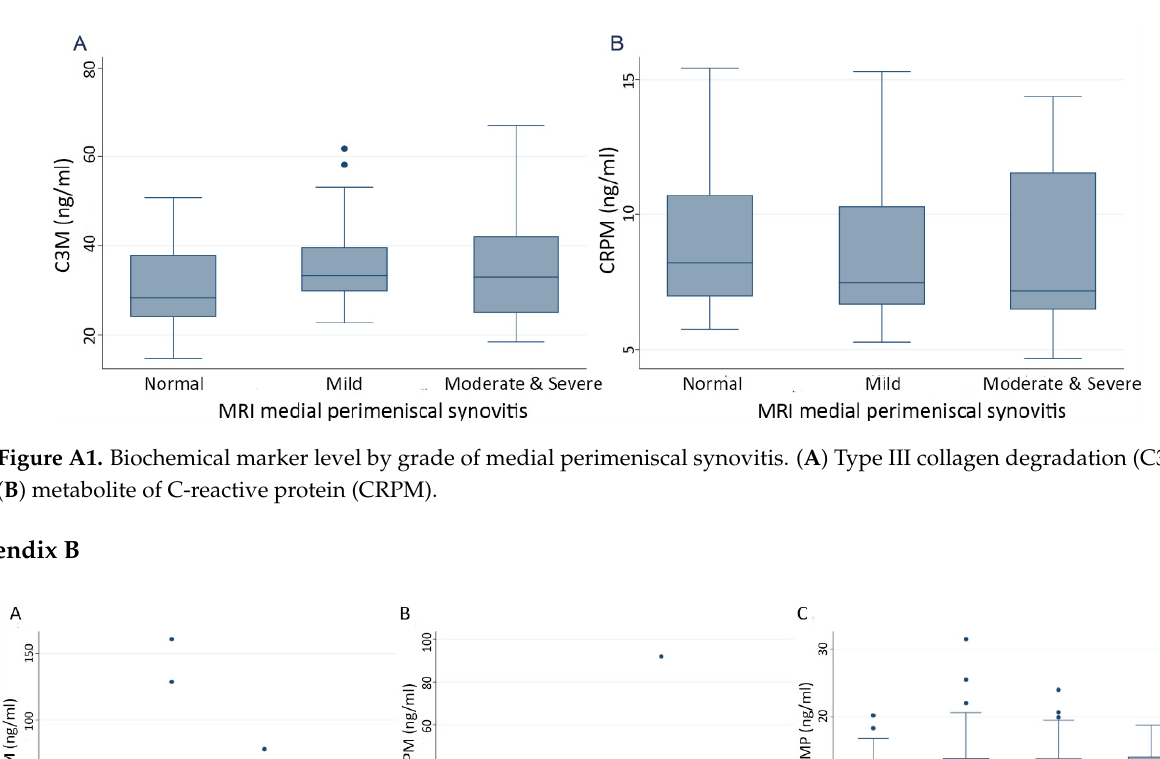
Figure A3. WOMAC pain score by Kellgren–Lawrence grade. ( A ) MRI imaging dataset; ( B ) bio- chemical markers dataset. References 1.